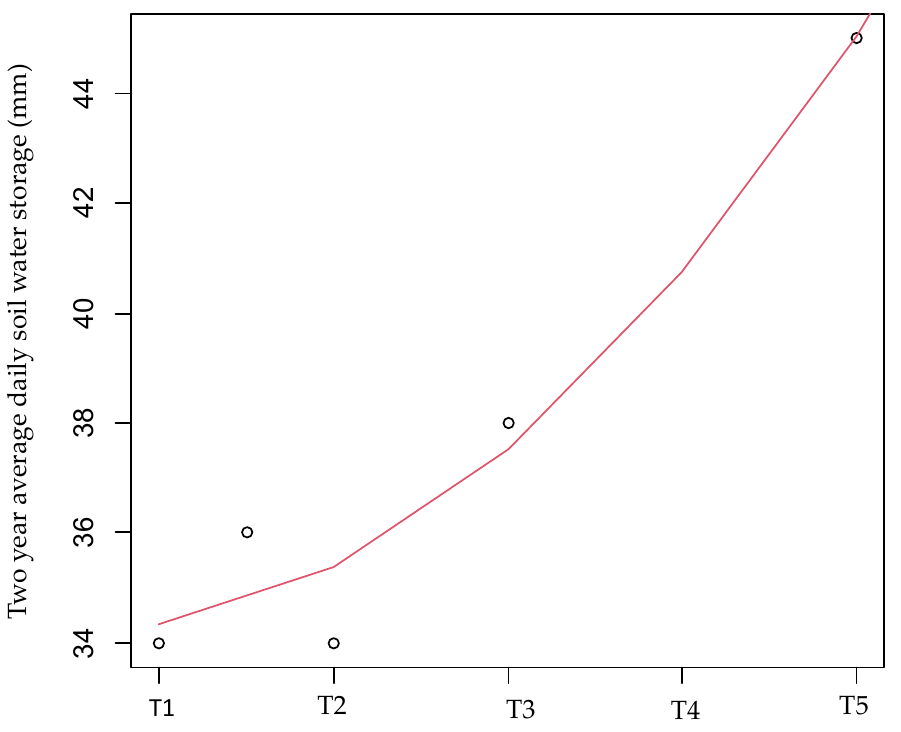
Figure 3. Regression model (y = 0.05409x 2 + 0.51586x + 34.32; R 2 = 0.9152; p = 0.02.) to describe the relationship between treatments (T1—0.0 kg; T2—0.5 kg; T3—1.0 kg; T4—2.0 kg; and T5—4.0 kg of biochar per plant) and two-year average daily soil water storage in the 0.0 to 0.3 m layer of the soil profile in Paraipaba, CE, Brazil.